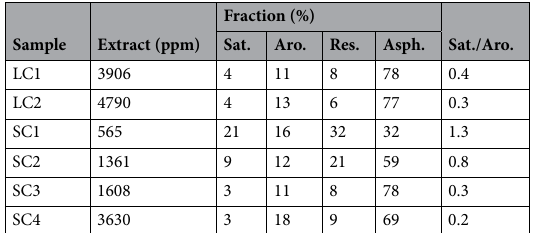
Fraction (%) Sat./Aro.Sat. Aro. Res.